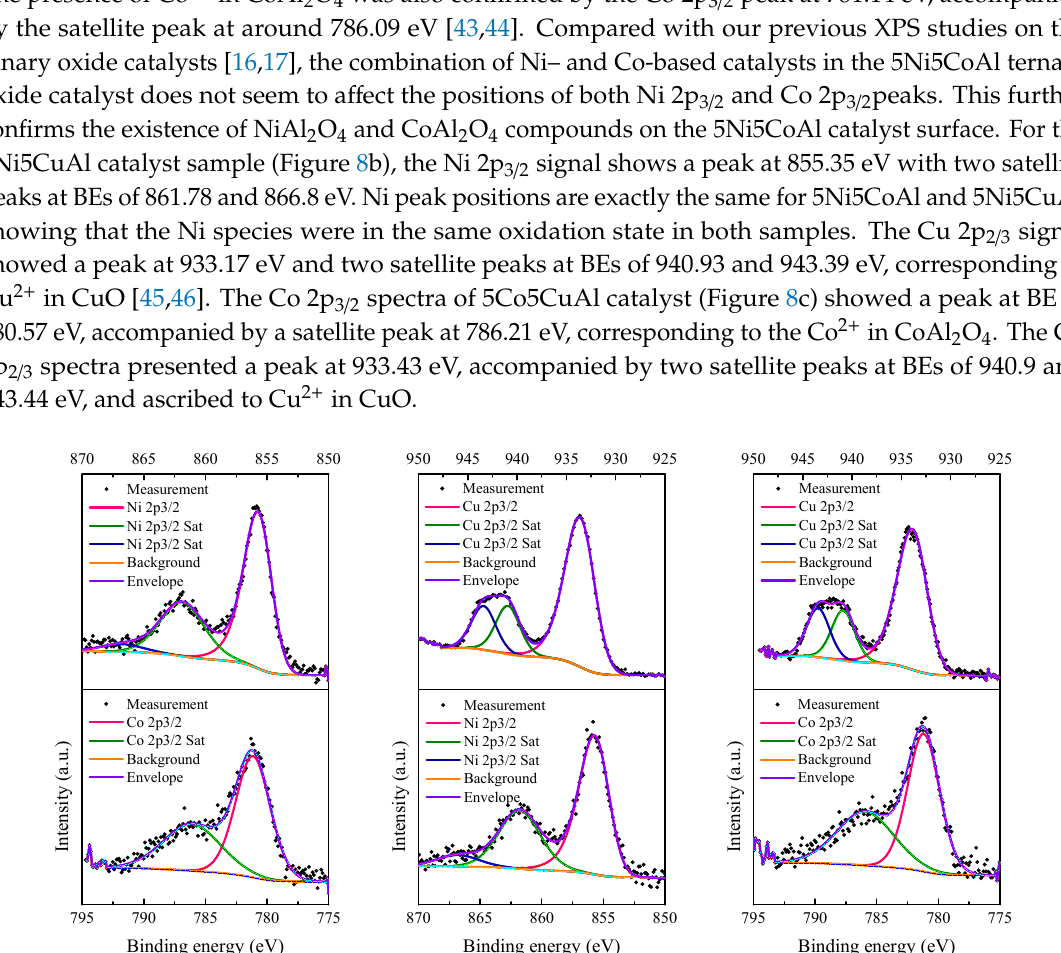
Figure 7. SAED patterns of the ( a ) 5Ni5CoAl ( b ) 5Ni5CuAl and ( c ) 5Co5CuAl catalyst samples.